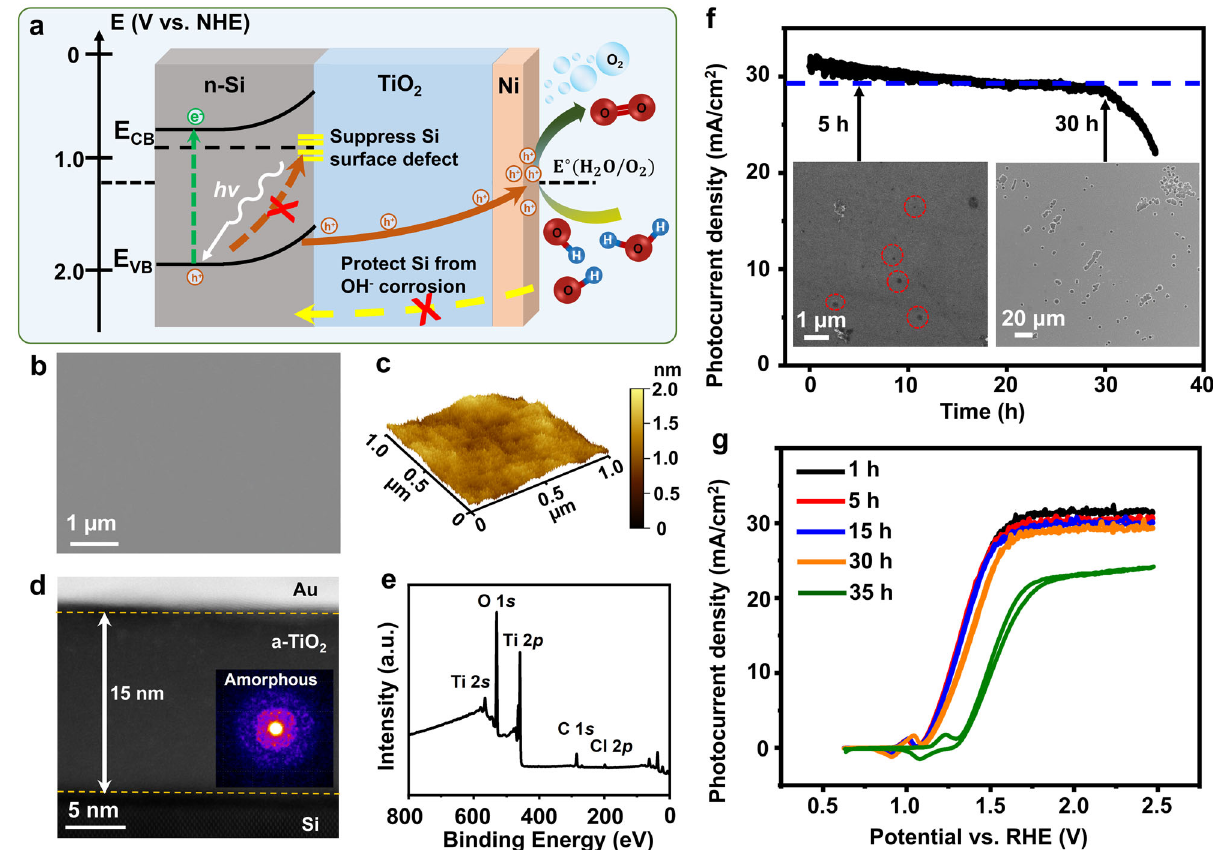
Fig. 1 | Si photoanodes protected by amorphous TiO 2 thin fi lm coating. a Schematics of a Si/TiO 2 /Ni photoanode for PEC water oxidation. The relevant electronicenergylevelsindifferentmaterialsareschematicallyshown.NHEnormal hydrogen electrode, CB conduction band, VB valence band. b SEM image of as- deposited amorphous TiO 2 thin fi lm on n-Si substrate. c AFM topography of the TiO 2 surface. d Cross-sectional STEM image of Si/TiO 2 . Inset is a nano-diffraction